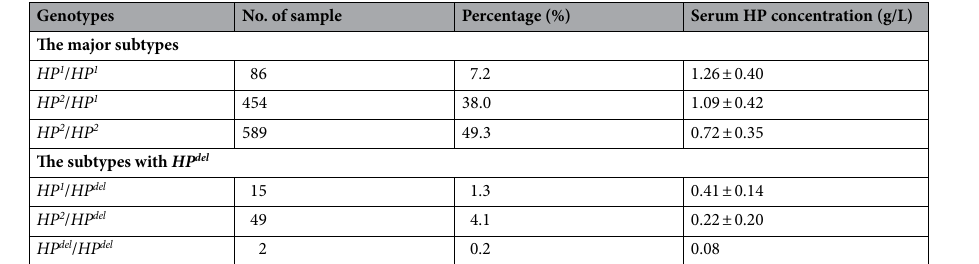
Genotypes No. of sample Percentage (%) Serum HP concentration